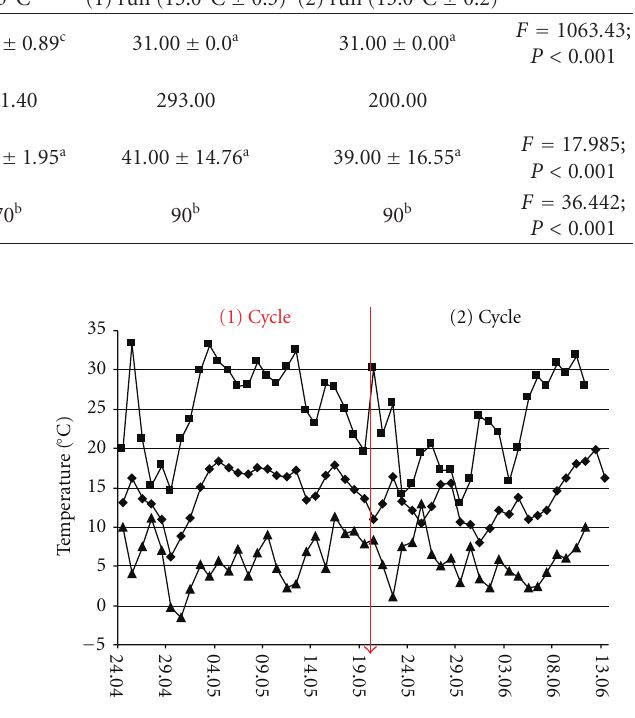
Figure 1: Temperature gradation for both cycles of the field experiment with mean ( (cid:2) ), maximum ( (cid:3) ), and minimum ( (cid:4) ) mean daily temperatures measured at 0.3 m height ( n =